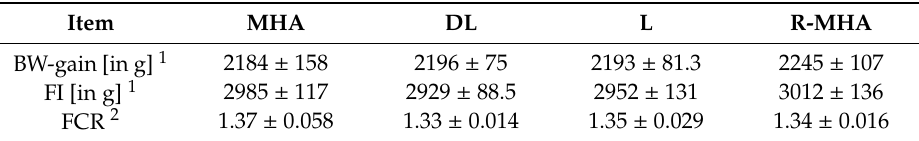
Table 5. In total: Mean of body weight (BW) gain, feed intake (FI), and feed conversion ratio (FCR) during the trial (days 1–34; mean ±